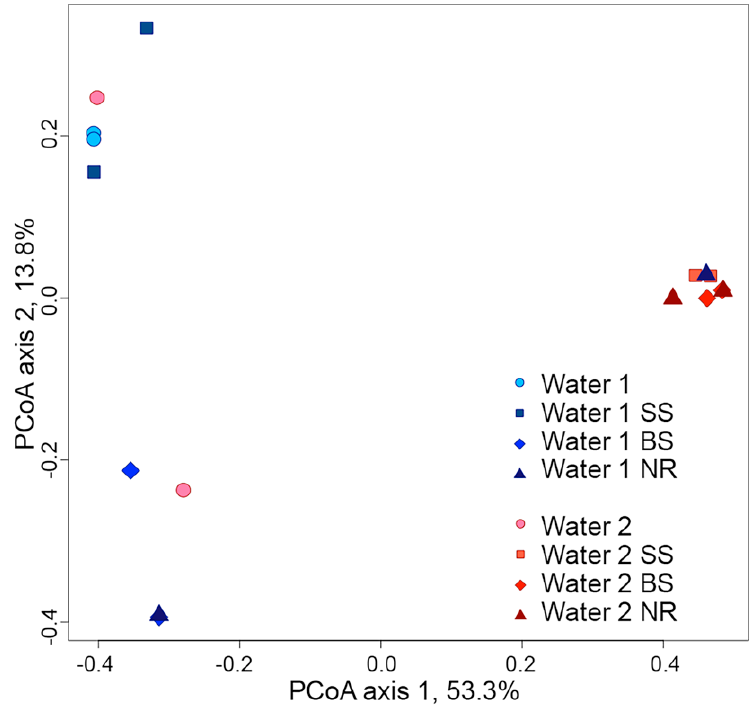
Figure 3. Principal coordinates analysis (PCoA) of the bacterial communities in the mine waters and 18-week microcosms based on unnormalized sequence read counts and Bray-Curtis dissimilarity model. Blue hues display Water 1 mine water and microcosms and red hues Water 2 mine water and microcosms. SS, BS and NR indicate microcosms containing sandstone, black shale and no rock, respectively. The percentage values on the axes indicate percentage of variation. Table 4. Relative amounts of sequence reads of unclassified bacteria, reads belonging to genera contributing with less than 1% of the sequences in any sample or belonging to major genera. SS—sandstone, BS—black shale, NR—no